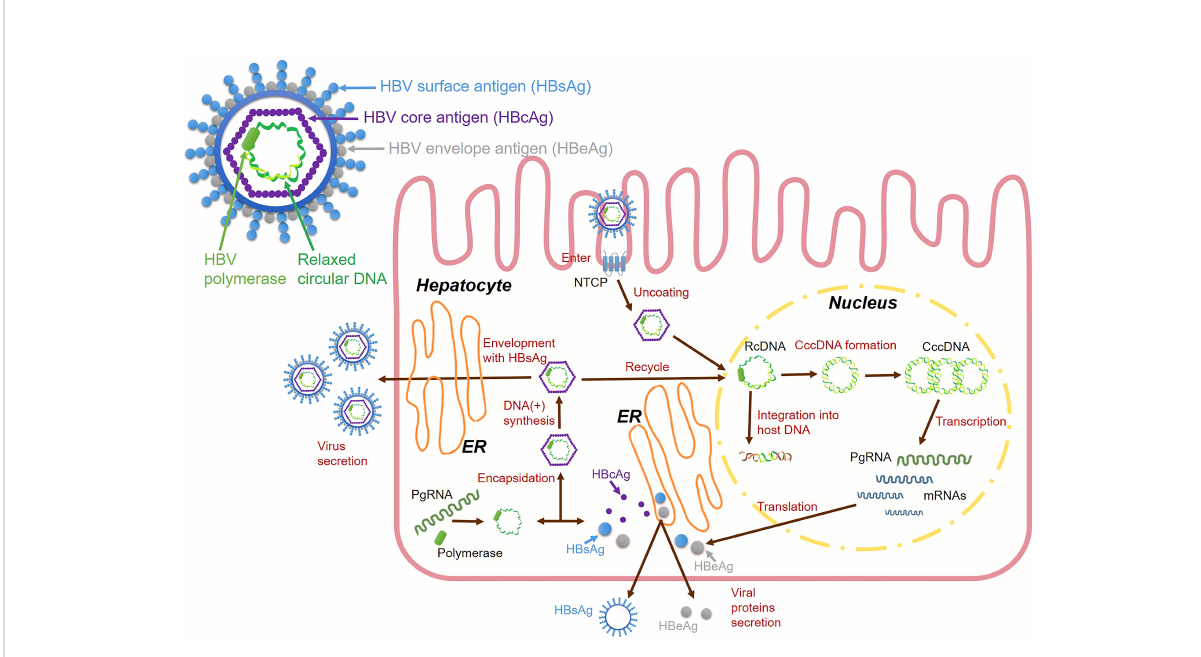
FIGURE 1 HBV virions and HBV life